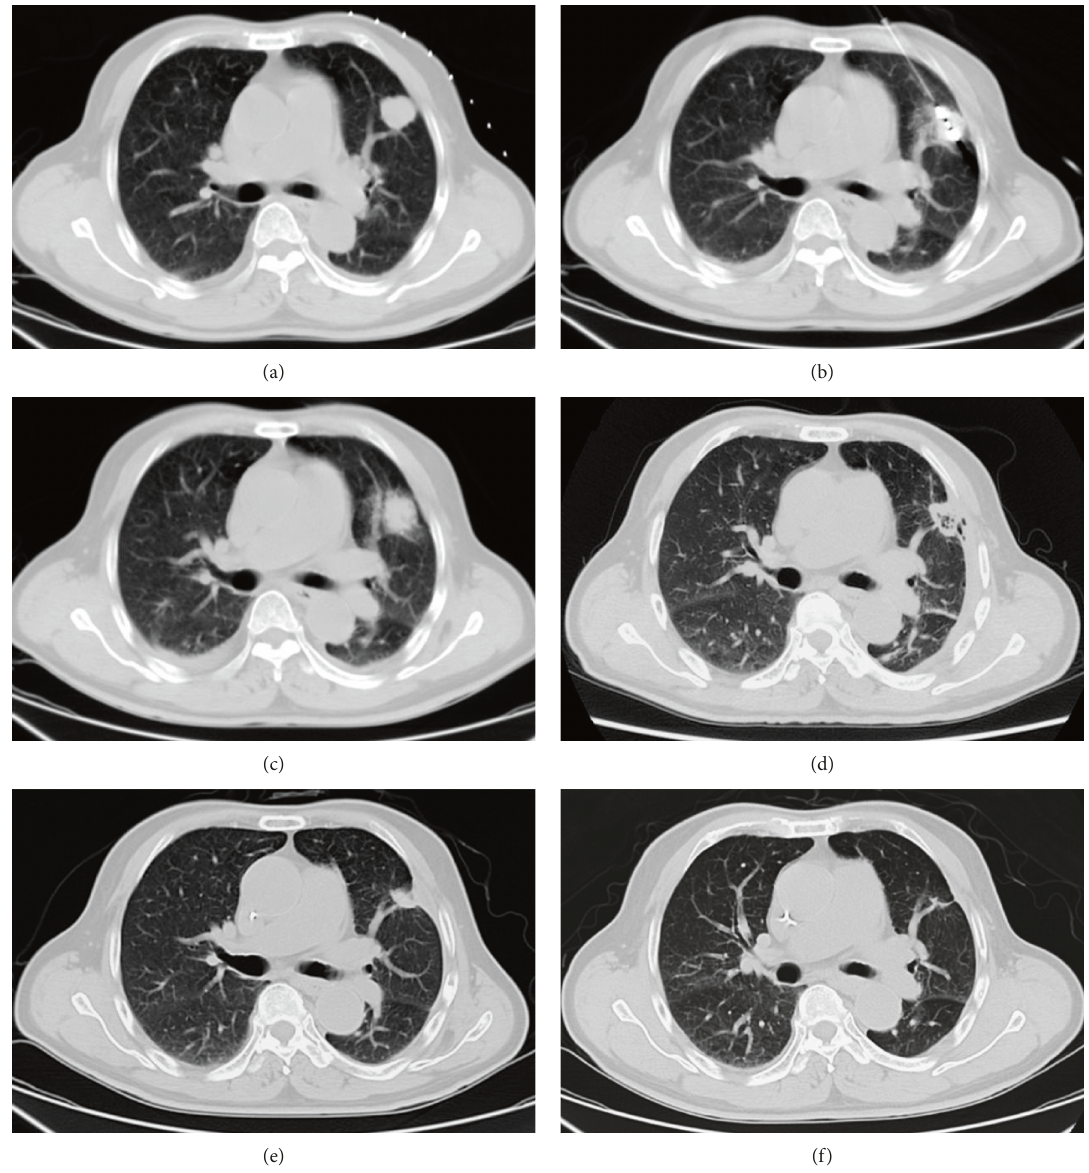
Figure 1: A 73-year-old man with lung metastasis from colorectal carcinoma in left upper lobe with an axial diameter of 2.3cm (a). Ablation was performed after accurate insertion of MWA probe into the focus of tumor (b). The immediate postoperative CT scan showed that the lesion enlarged slightly with ill-de fi ned and irregular margin (c). The lesion was shrunk gradually and replaced by fi brous tissue during 1 (d), 3 (e), and 6 (f) months